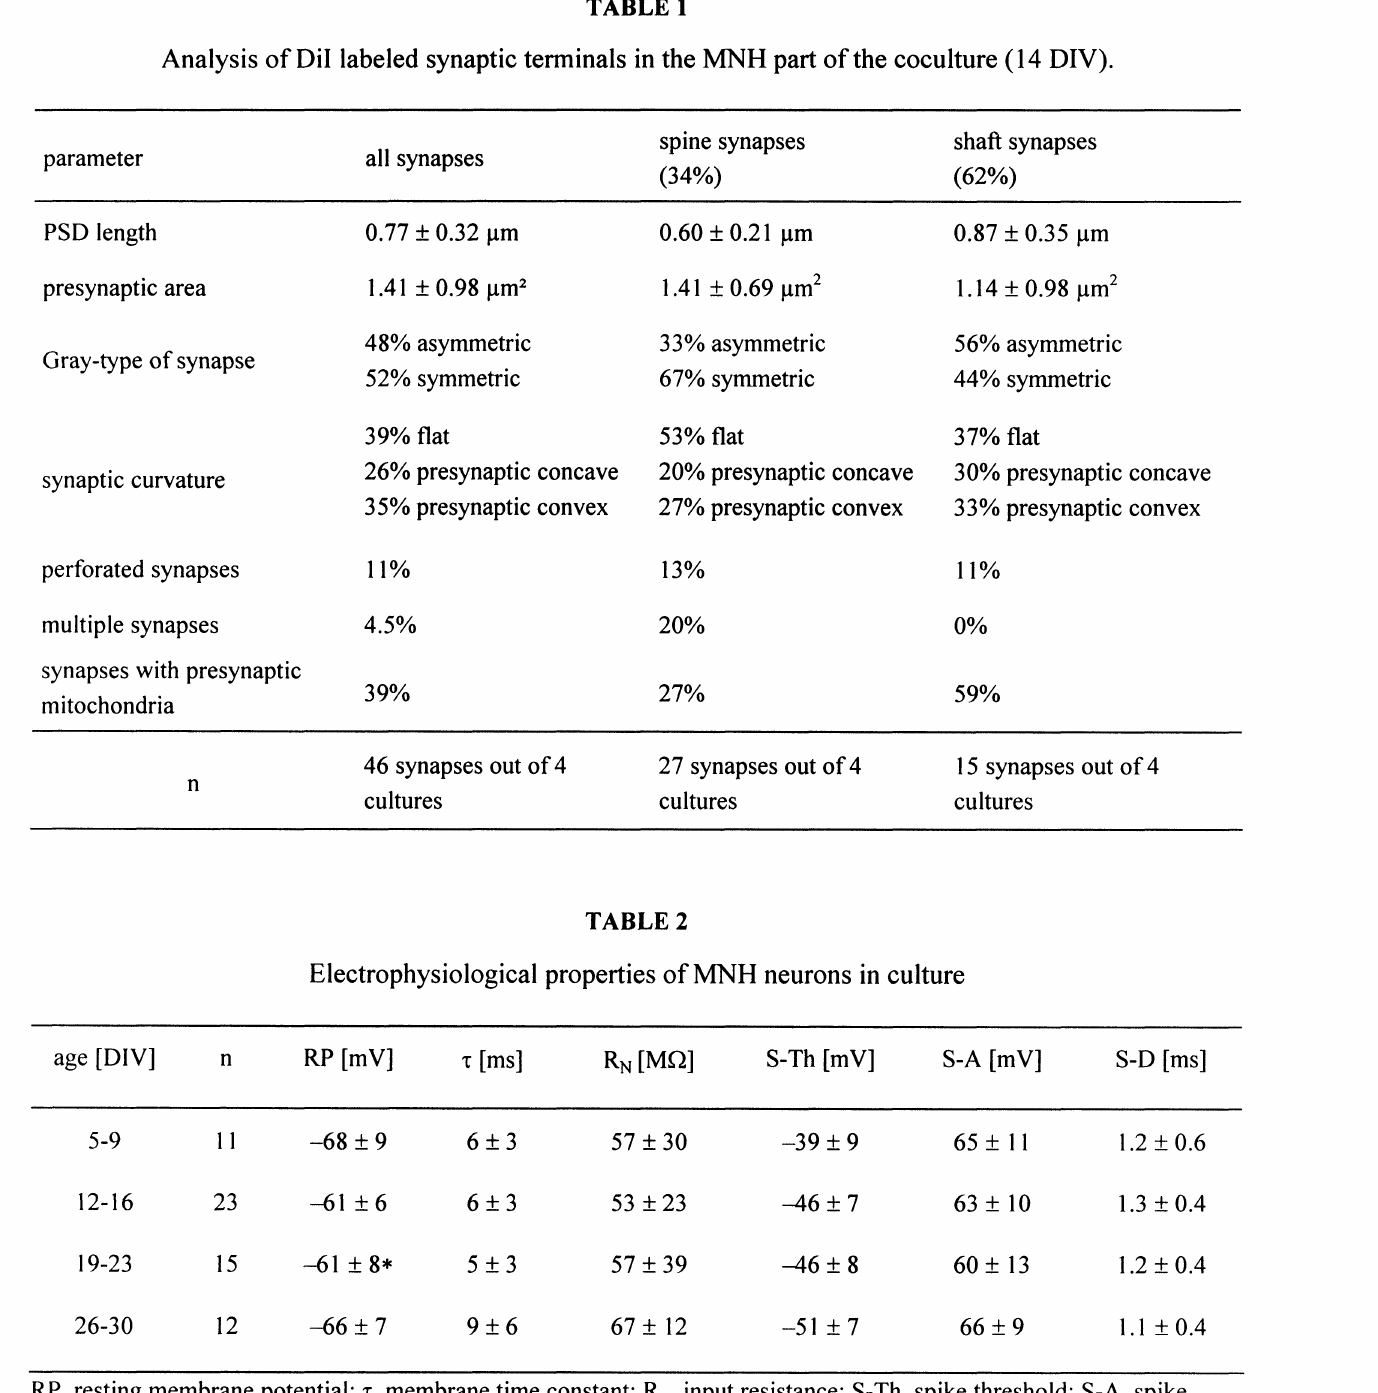
Analysis of Dil labeled synaptic terminals in the MNH part of the coculture (14 DIV). parameter